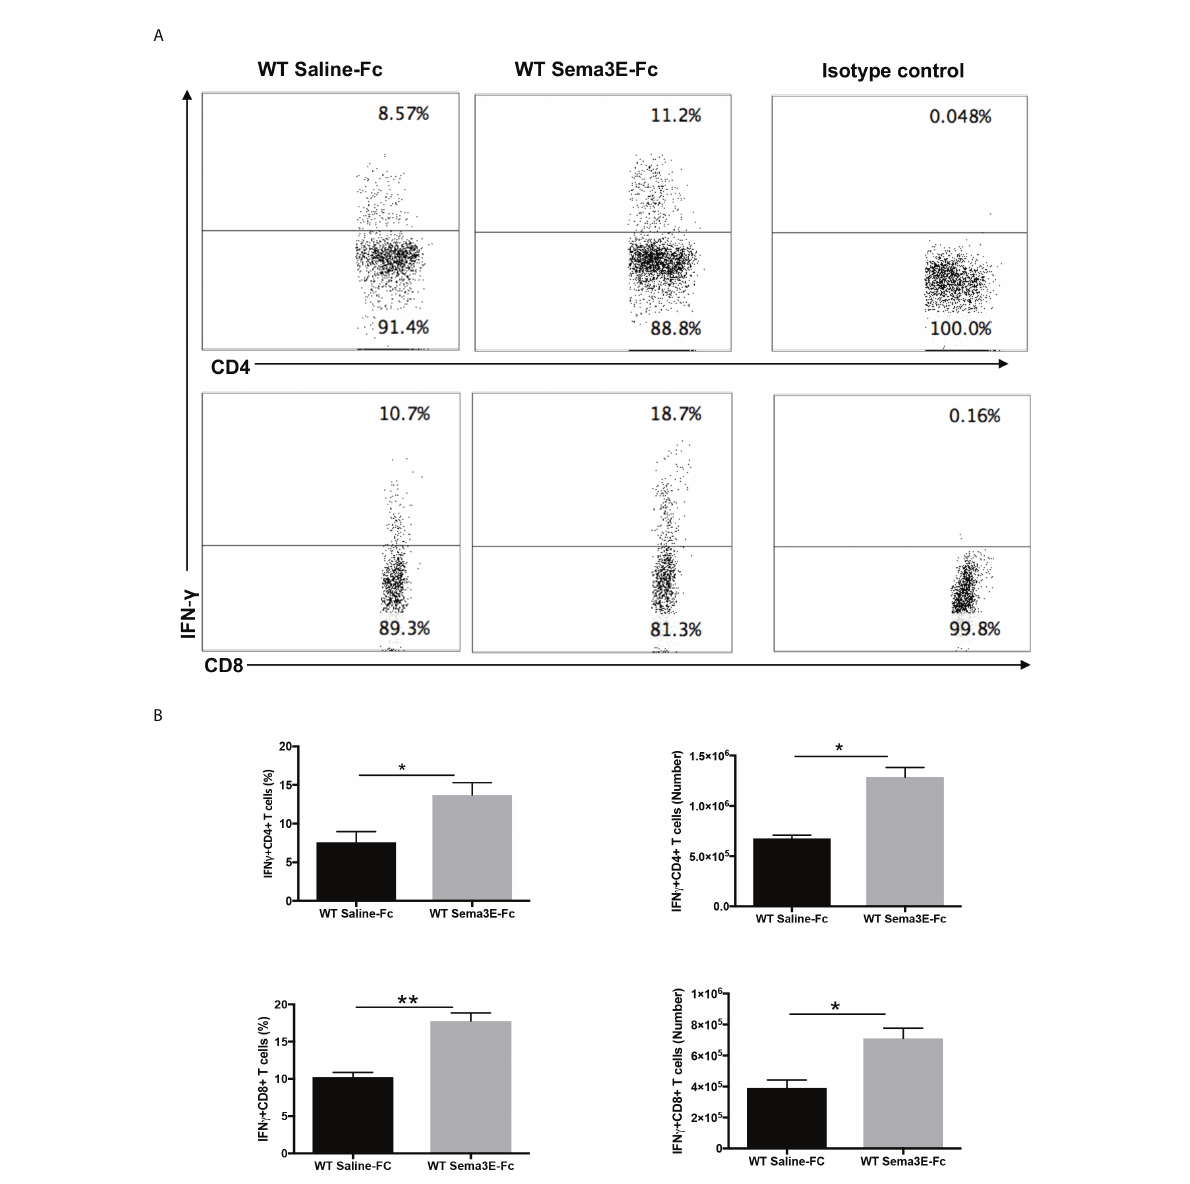
FIGURE 3 Higher IFN- g production by CD4 and CD8 T cells after Sema3E-Fc treatment of Cm infected WT mice. CD4 + and CD8 + T cells isolated from the lungs of Cm infected mice at day 7 post-infection were stained intracellularly for IFN- g . (A) Representative fl ow cytometric images and summary of fl ow cytometric analysis (B) to show the percentage and absolute number of IFN- g producing CD4 and CD8 T cells. Data are shown as mean ± SD (n = 3) and represent one of three independent experiments with similar results. * p < 0.05, ** p <